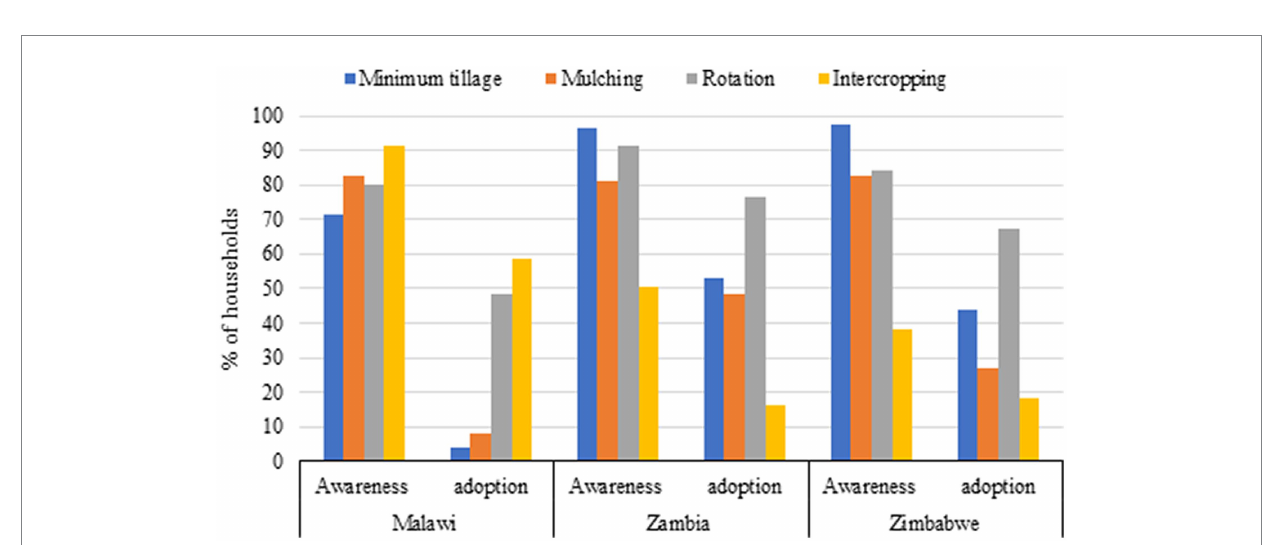
FIGURE 5 Awareness and adoption of CA practices by country and CA practices (% of households).